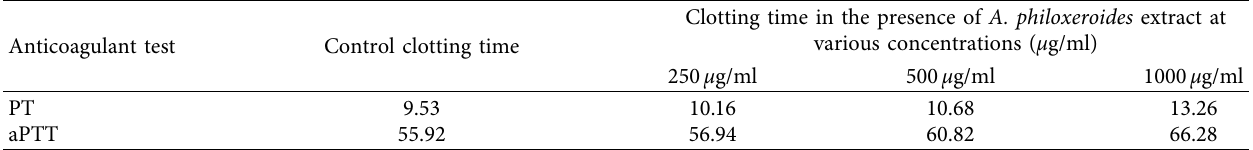
Here, the values are expressed in time